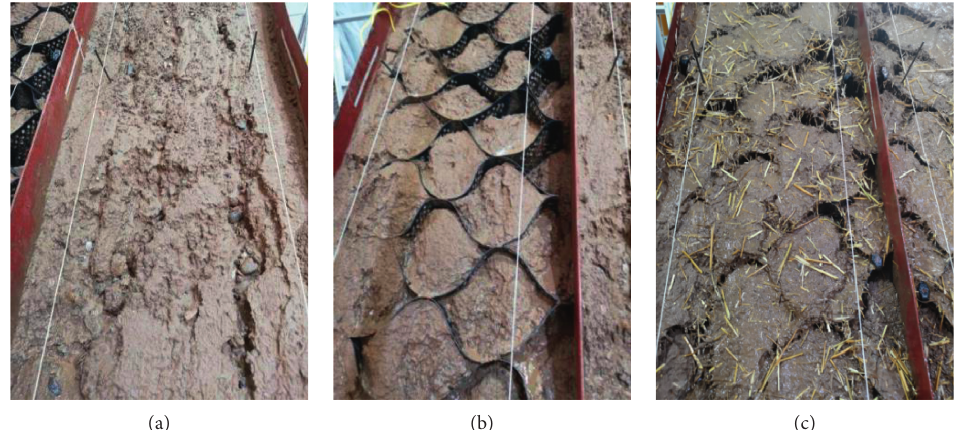
Figure 7: Comparison of slope erosion after rainfall: (a) unsupported slope; (b) geocell-reinforced slope; (c) geocell- and wheat straw- reinforced